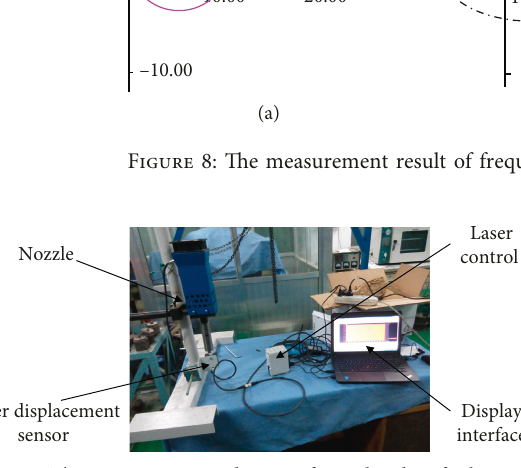
Figure 9: The measurement device of amplitude of ultrasonic